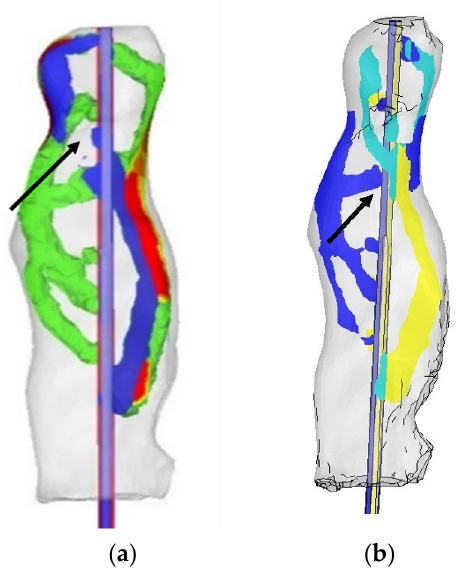
Figure 10. Design variant: ( a ) section cut (in blue); ( b ) density distribution.